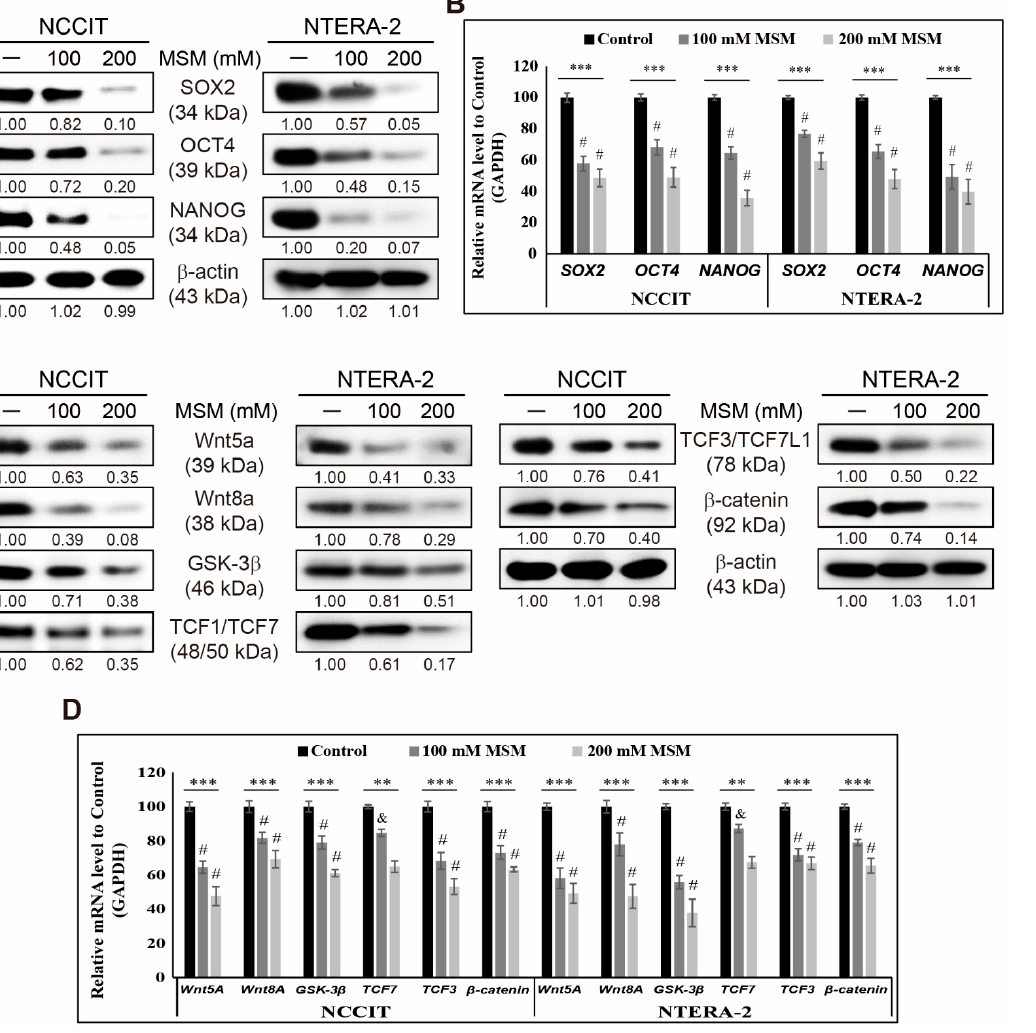
Figure 1. MSM inhibits CSC markers and Wnt/ β -catenin signaling. ( A ) Western blotting of SOX2, OCT4, and NANOG proteins in NCCIT and NTERA-2 cells after treatment with 100 and 200 mM MSM for 48 h. Expression levels were estimated by densitometry and normalized to β -actin. Data were obtained in triplicate. ( B ) Real-time qPCR showing illustrative expression of SOX2, OCT4, and NANOG genes in NCCIT and NTERA-2 cells. Cp values were normalized to GAPDH mRNA. Controls were set at 100. *** p < 0.001 (ANOVA). # p < 0.001 vs. control. ( C ) Western blotting of Wnt5a, Wnt8A, GSK-3 β , β -catenin, TCF1/TCF7, and TCF3/TCF7L1 proteins in NCCIT and NTERA-2 cells after treatment with 100 and 200 mM MSM for 48 h. Expression levels of proteins were estimated by densitometry and normalized to β -actin. Experiments were conducted in triplicate. ( D ) Real-time qPCR showing illustrative expression of Wnt5a, Wnt8A, GSK-3 β , β -catenin, TCF7, and TCF3 genes in NCCIT and NTERA-2 cells. Cp values were normalized to GAPDH mRNA. Controls were set at 100. ** p < 0.01 (ANOVA). & p < 0.01 vs. control. *** p < 0.001 (ANOVA). # p < 0.001 vs. control.